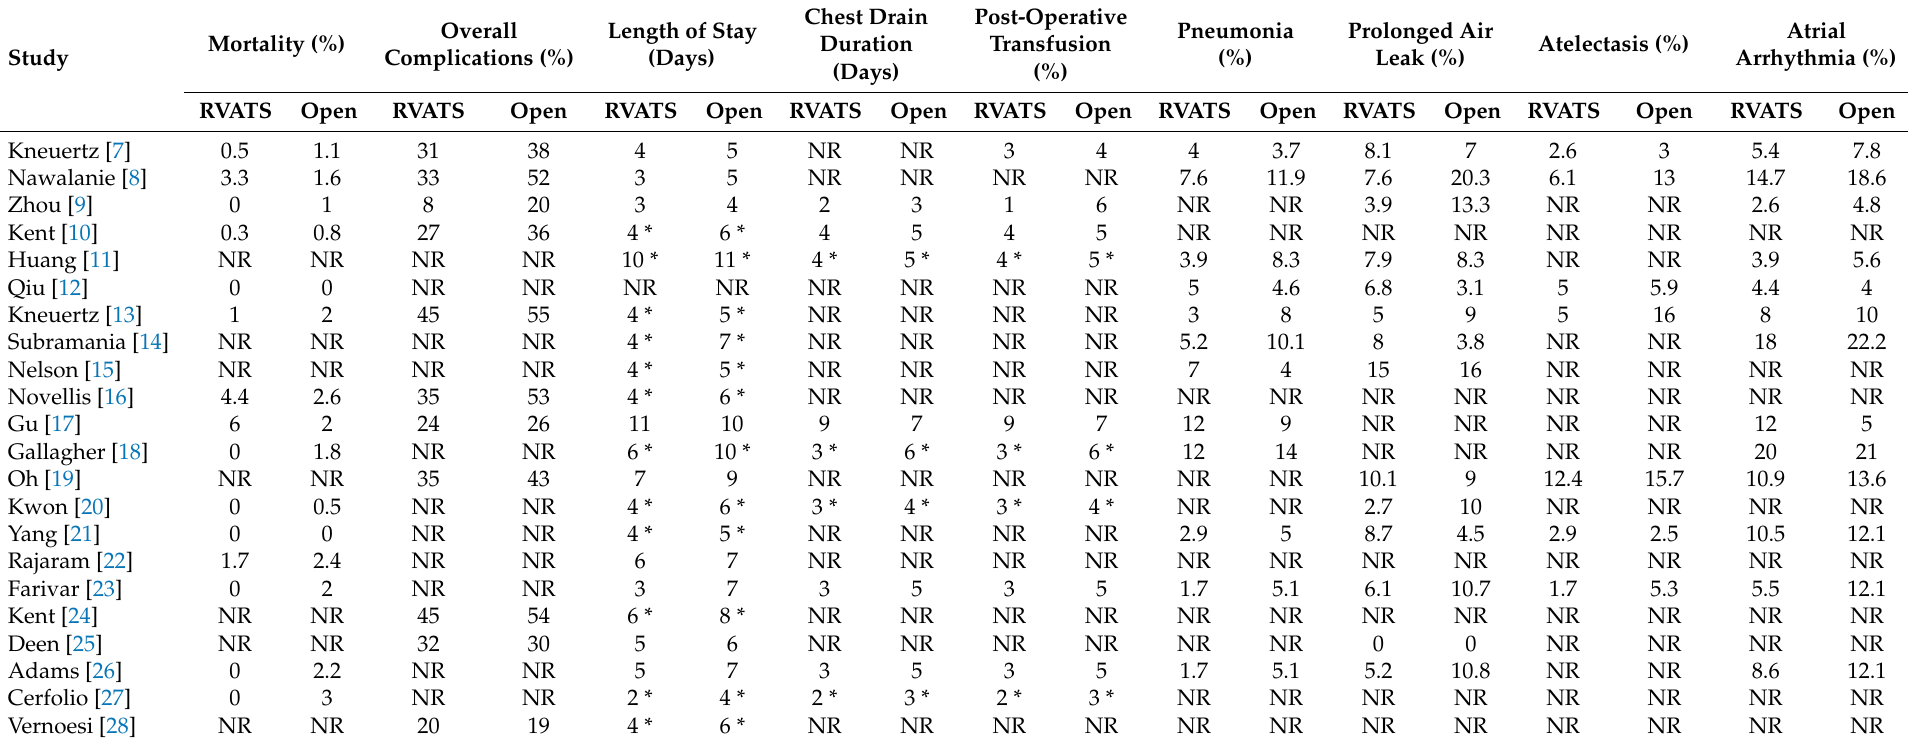
Table 4. Summary of postoperative outcomes of patients who underwent robotic video-assisted thoracoscopic surgery compared with open thoracotomy for resectable non-small cell lung